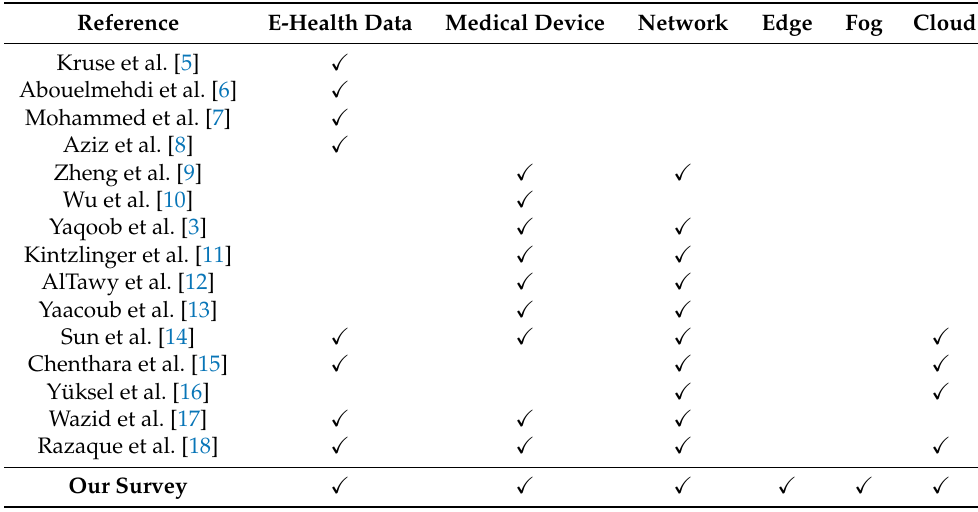
Table 2. Comparison of the survey papers in terms of the target